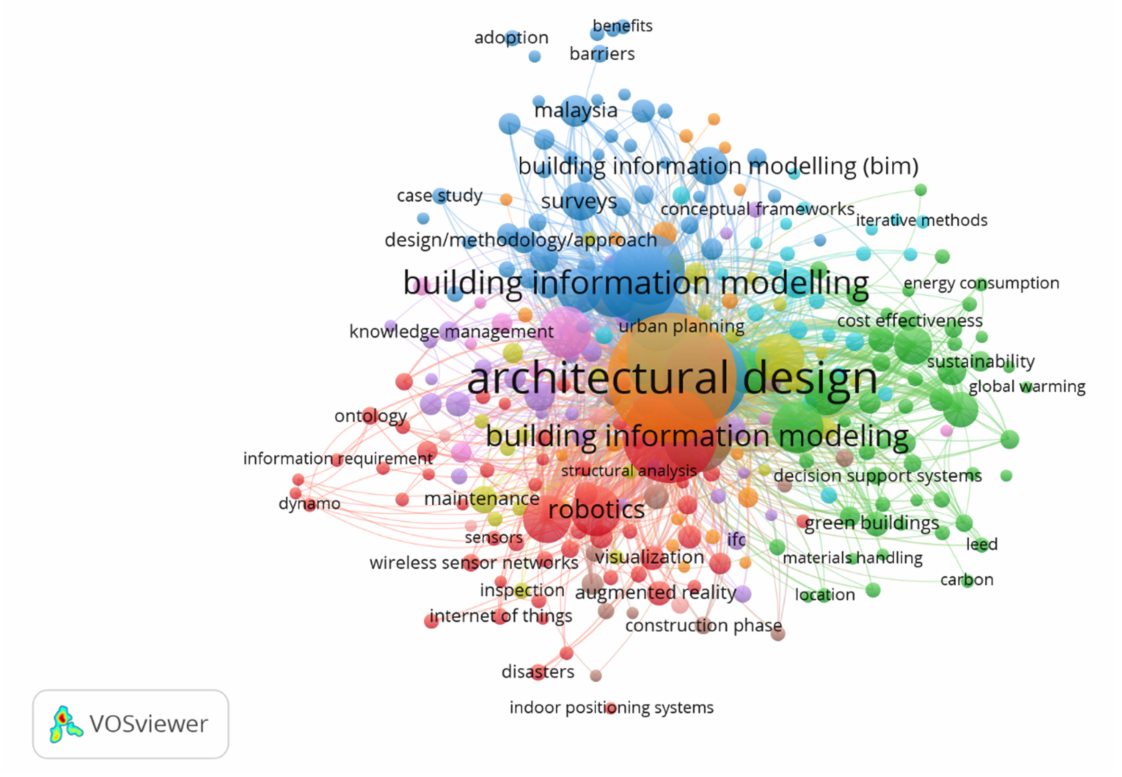
Figure 10. Keyword citation